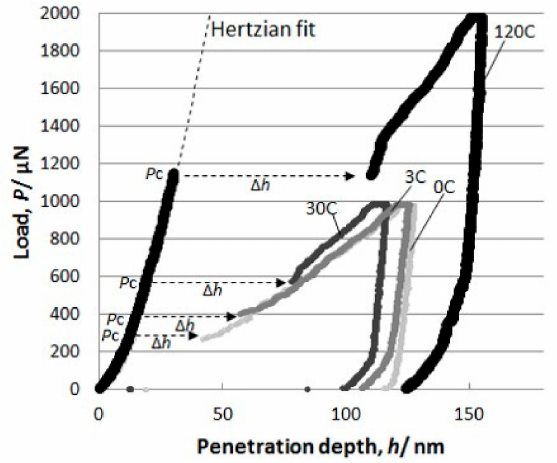
Figure 11. Typical load–displacement curves obtained by nanoindentation of Fe–C binary alloys with various C contents [132].